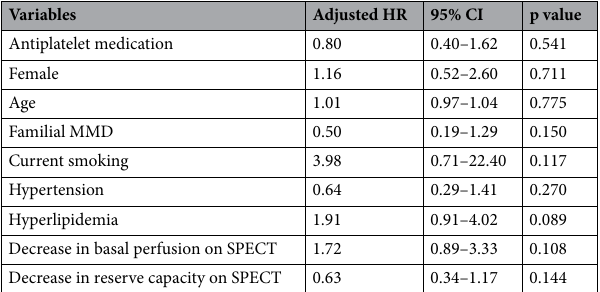
Table 5. Logistic regression analysis of improvement of ischemic symptoms associated with antiplatelet medication during the follow-up. p < 0.05 statistically significant. MMD moyamoya disease, SPECT single photon emission computed